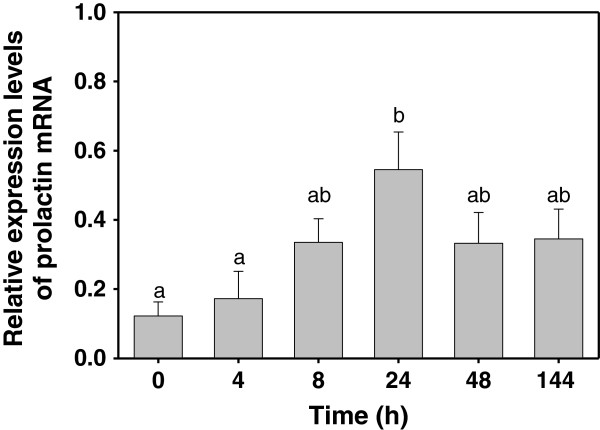
Analysis of PRL mRNA level in cinnamon clownfish A. melanopus upon exposure to 15 ppt. Total RNA(0.5μg) prepared from pituitary gland was used for generating cDNA by reverse transcription followed by PCR amplification using PRL-specific primers. Levels of β-actin mRNA were evaluated as a control. The expression level of each prolactin mRNA was normalized with respect to the level of β-actin transcript. Each value represents the mean±SE (n=4) and the same letters indicate no significant difference (P>0.05).